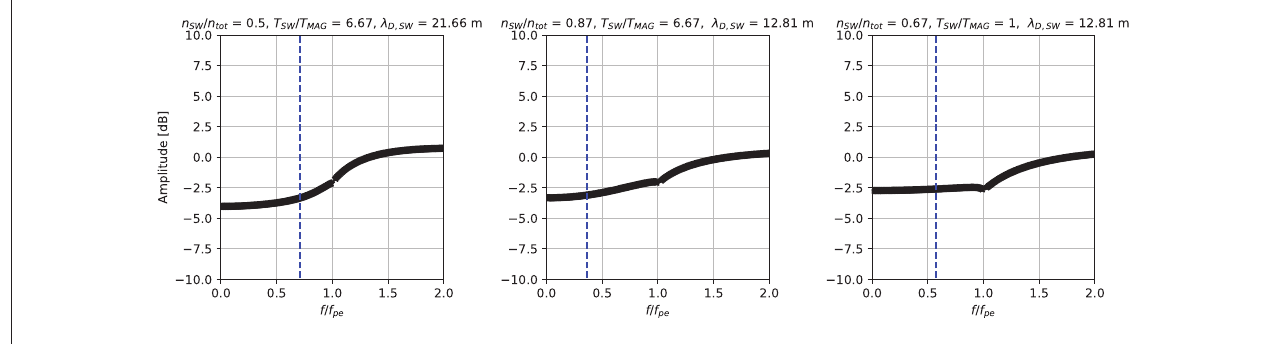
FIGURE 8 | Modeled AM 2 P spectra in three different plasma with a mix of electrons from the solar wind origin and the electrons from the magnetosheath, both modeled by a Maxwellian evdf. The amplitude is expressed in 20 log 10 and the frequency is normalized by the electron plasma frequency. The core plasma frequency is shown by the blue vertical dotted lines.